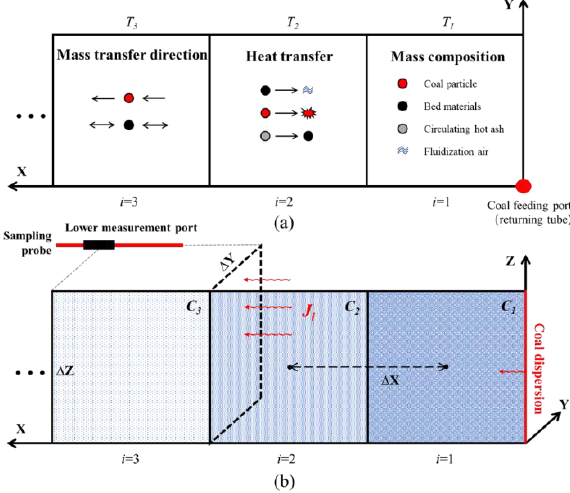
Figure 4. A schematic diagram of the lateral fuel dispersion process based on the local heat balance method (( a ) materials involved in the combustion and heat transfer during solid dispersion; ( b ) dispersion flux of fuel particles passing through cells).